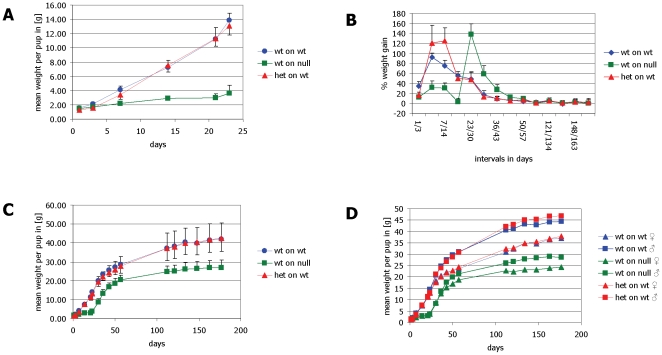
Impact of α-casein deficient milk on pup growth.
Panel A: Growth curve of three different groups of mice during lactation (G1: wild-type pups nursed by wild-type dams n = 34; G2: wild-type pups nursed by α-casein deficient [−/−] dams, n = 25; and G3: heterozygous pups nursed by wild-type dams, n = 22). Values shown are +/− standard deviation. All weight differences between group G2 vs. G1 and G3 were significant from day 7 (p<0.001) as assessed by ANOVA. Panel B: Percentage weight gain throughout different stages of life for the three experimental groups. The weight of individual mice was compared on two days (as indicated: e.g. 1/3 corresponds to the interval between day 3 and day 1 of life) and the percent weight increase was recorded. The average for all mice in the three experimental groups is shown for consecutive time periods. Panel C: Growth curve of mice in the three groups over the first 6 months of life. Mice nursed by α-casein deficient dams show a consistent growth deficiency. Panel D: Growth curve of mice in the three groups of mice over the first 6 months of life separated by gender. Error bars represent standard deviations.